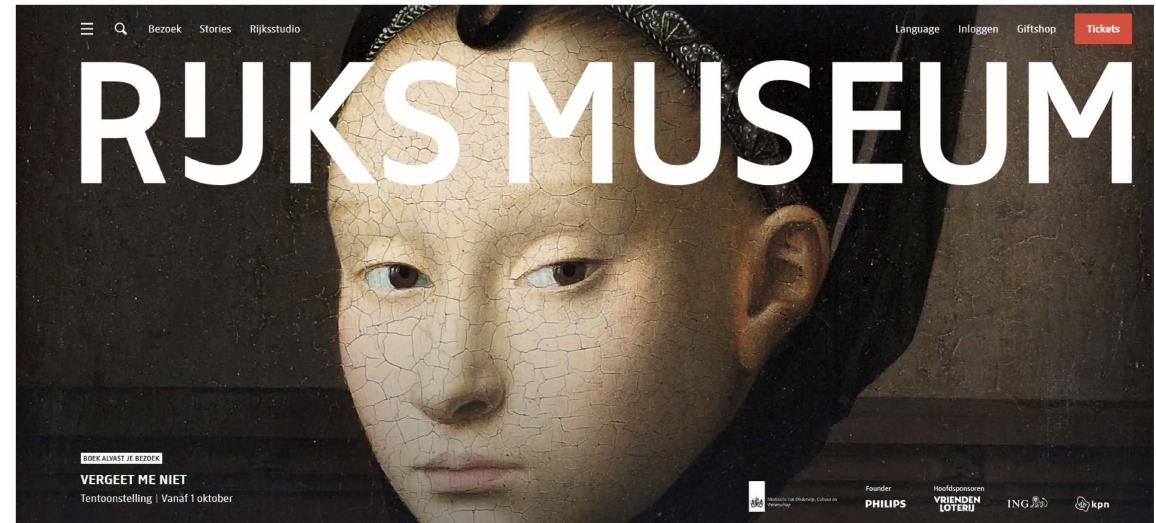
Figure 4. The website of the Rijksmuseum on 30 September